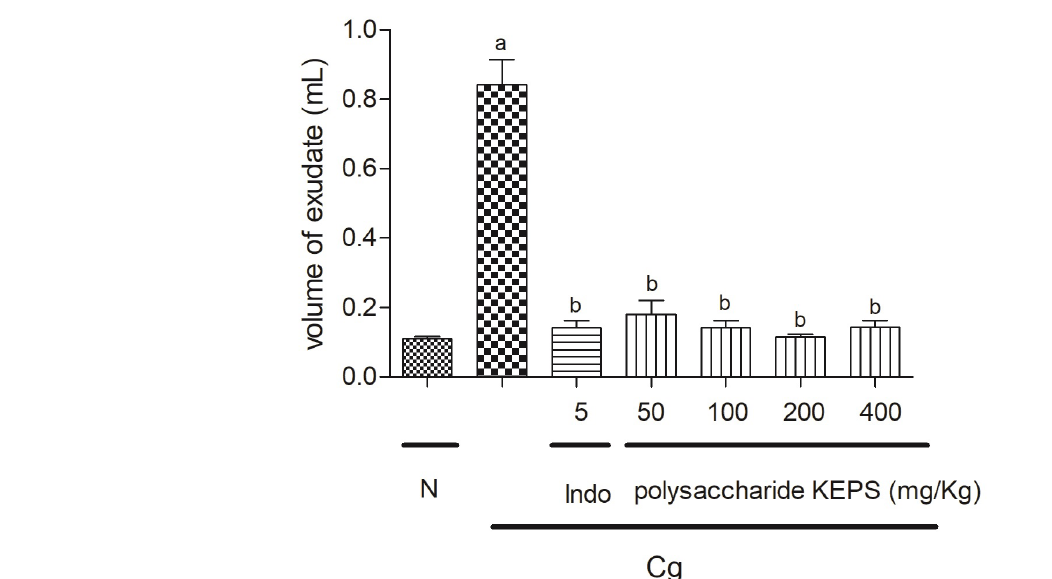
FIGURE 3 - KEPS effect on the volume of pleural inflammatory exudate. The pleurisy was induced by intrapleural carrageenan injection (Cg - 200 µg/cavity) in rats (n = 6–7), 1 h following subcutaneous administration of the EPS at 50, 100, 200, 400 mg/ kg or saline (Cg). Indomethacin (Indo, 5 mg/kg) was subcutaneously administered as an anti-inflammatory reference drug (positive control). N = normal animals that received no pleural injection of carrageenan. Each point represents the mean ± standard error of the mean of the volume of exudate 4 h after injection of carrageenan. a p < 0.05 when compared with normal rats; b p < 0.05 when compared with group of rats injected with carrageenan and untreated (Cg) (ANOVA, Tukey’s test). TABLE IV - KEPS effect on the number of total and differential leukocytes in pleural inflammatory exudate of rats